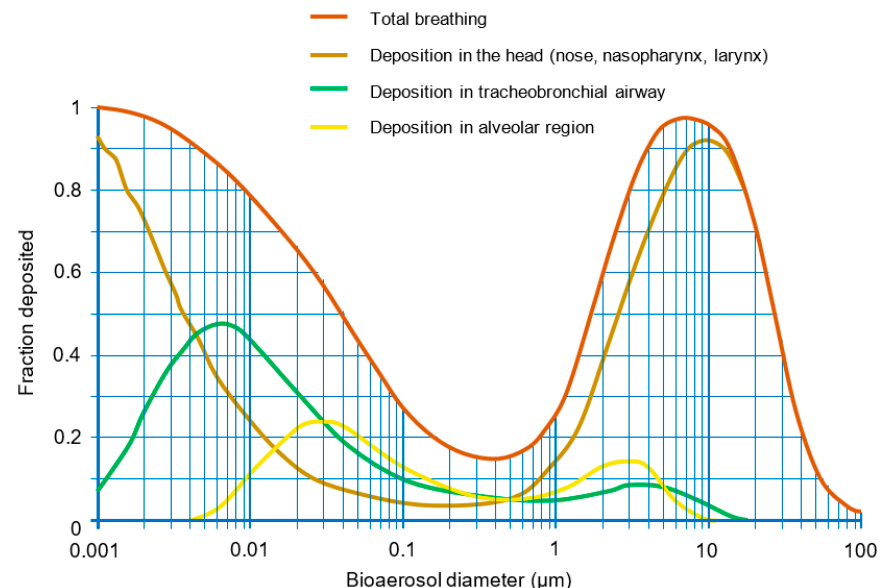
Figure 2. Mathematical model of particle deposition of nasal breathing [7]. Table 1. Average emission per person and event [8].